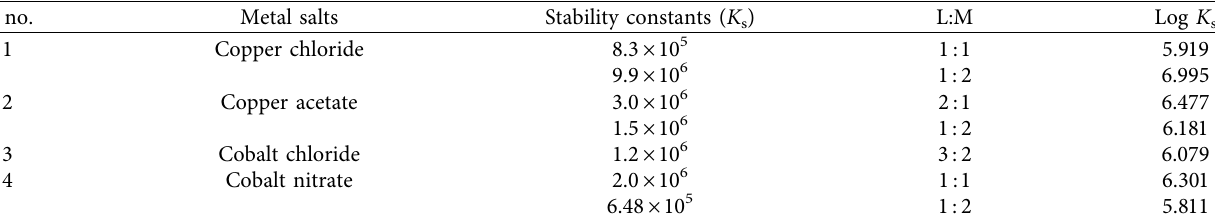
Table 2: Stability constants of metal precursors with DMBH.